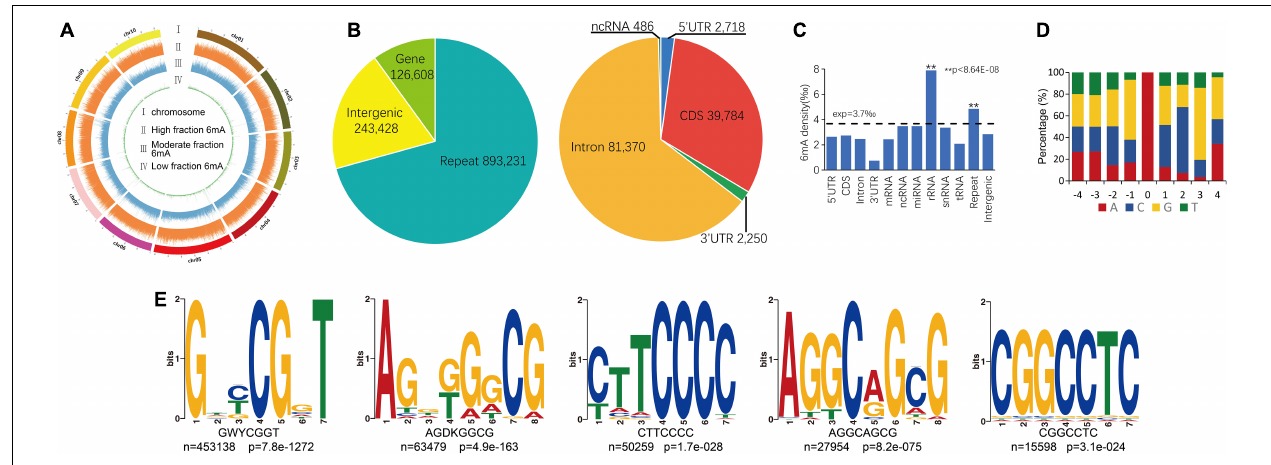
FIGURE 1 | Overview of 6mA in global genome. (A) 6mA distribution mapping across chromosomes. (B) 6mA sites in different genomic regions. (C) 6mA densities in different regions. (D) Content percentage of the bases A, T, C, and G in the upstream and downstream 4 bp of 6mA sites (position “0”). (E) The motif sequences of 6mA detected by STREME assay, the name of the motif, the number of positive sequences matching the motif (n) and the corresponding p -value generated by STREME are shown under the logo. ∗∗ means statistical extreme significant difference.